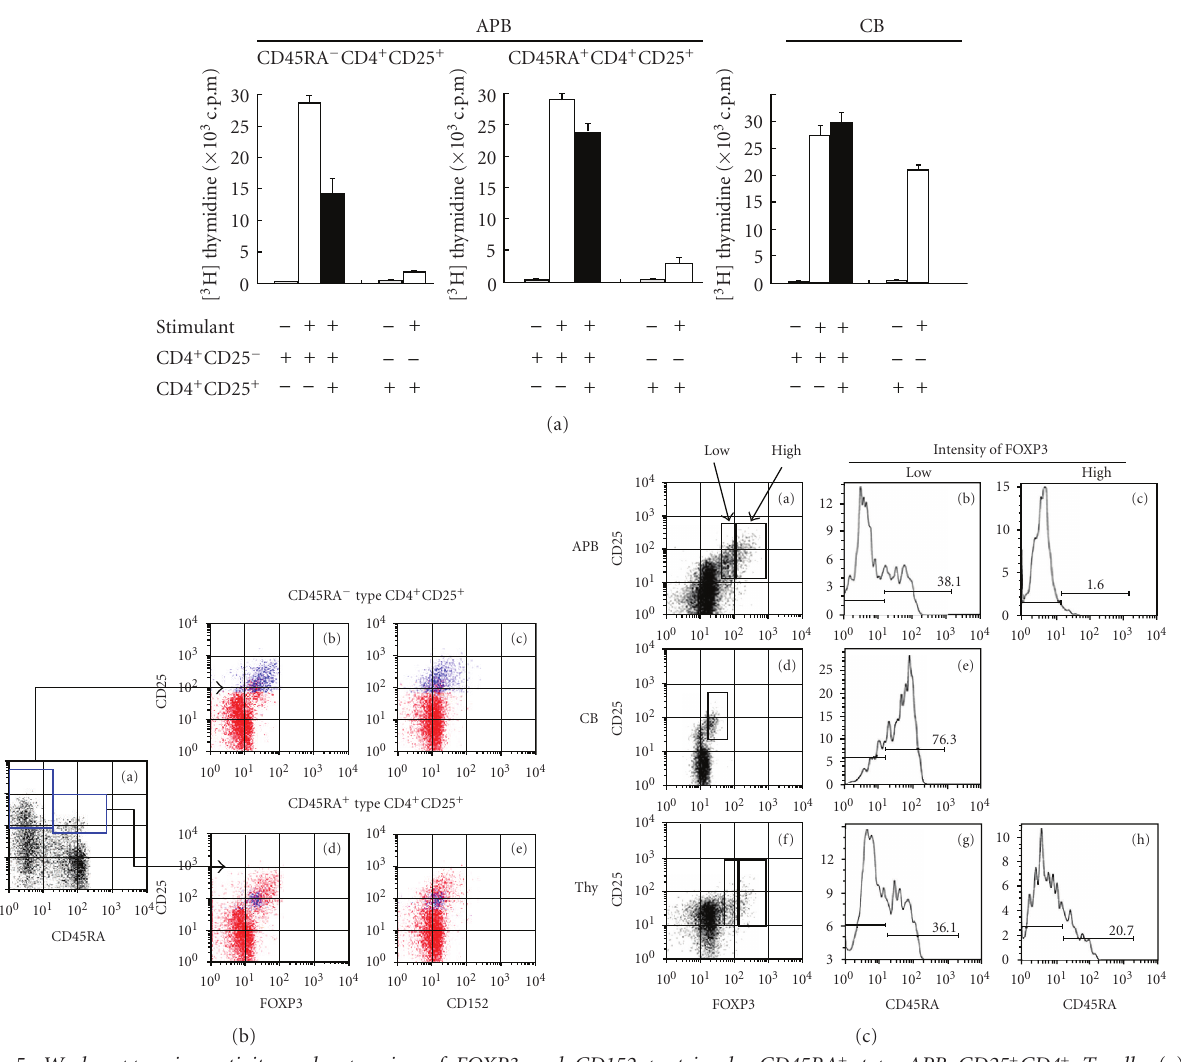
Figure 5: Weak suppressive activity and expression of FOXP3 and CD152 proteins by CD45RA + type APB CD25 + CD4 + T cells. (a) CD45RA + CD25 + CD4 + , CD45RA − CD25 + CD4 + , and CD25 − CD4 + cells were sorted and incubated under the indicated conditions as described in Section 2. Cell proliferation was assessed by 3 H-thymidine uptake on day 4. Data are representative of 3 di ff erent donors. (b) Mononuclear cells from APB were multistained with anti-CD4, anti-CD8, anti-CD25, anti-CD45RA, anti-FOXP3, and anti-CD152 Abs as described in Table 1. The profiles were gated initially for CD8 − CD4 + , then CD45RA − type or CD45RA + type CD25 + CD4 + T cells were gated based on the expression of CD45RA and CD25 in panel (a). The expressions of CD25 versus endogenous FOXP3 or CD152 in CD45RA − type (panels (b) and (c)) or CD45RA + type CD25 + CD4 + T cells (panels (d) and (e)) were merged as blue dots to those in CD8 − CD4 + cells (red dots in panels (b)–(e)). Data are representative of 10 di ff erent donors. (c) Mononuclear cells or thymocytes were multistained as described in Figure 4(b). On the basis of FOXP3 expression, FOXP3 high or FOXP3 low was gated (panels (a), (d), (f)). In each population, histogram of CD45RA expression was shown (panels (b), (c), (e), (g),